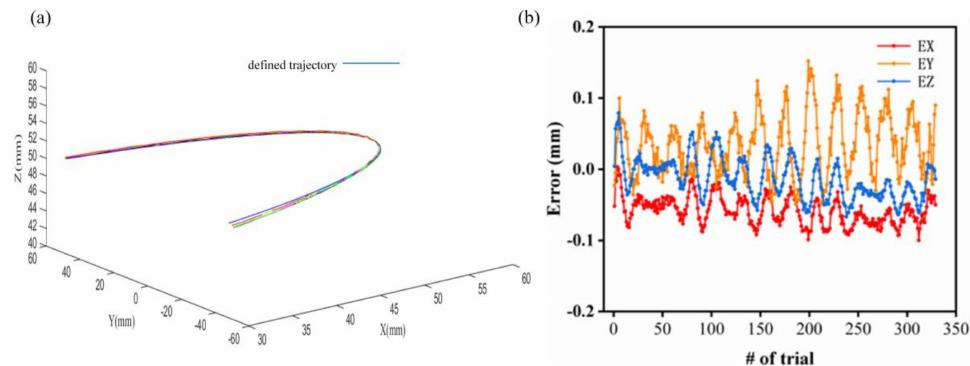
Figure 10. Repeated experiments for a given trajectory: ( a ) repeated experiments for a given trajectory; ( b ) the deviation between the actual position and the given